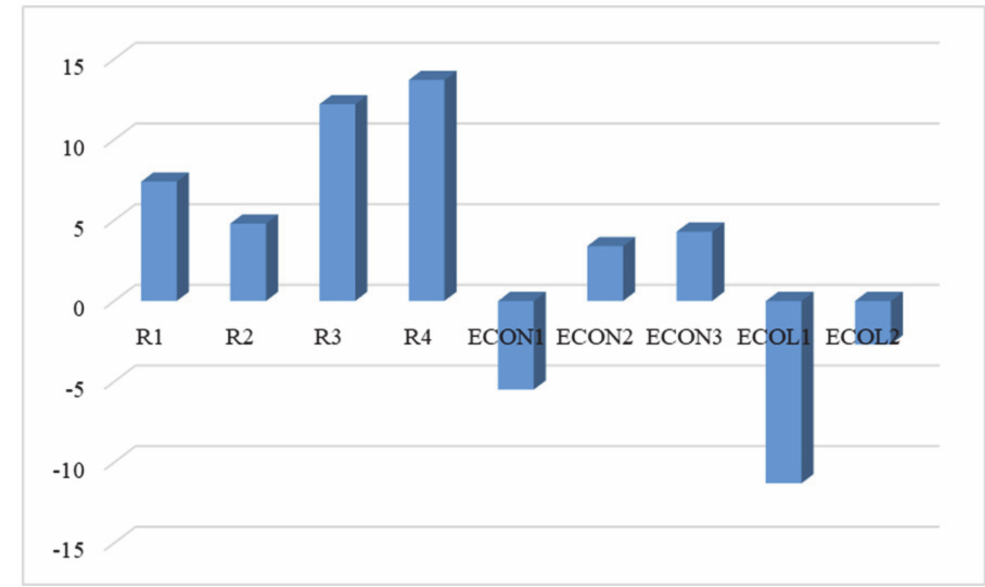
Figure 4. The changes in EU average during the period